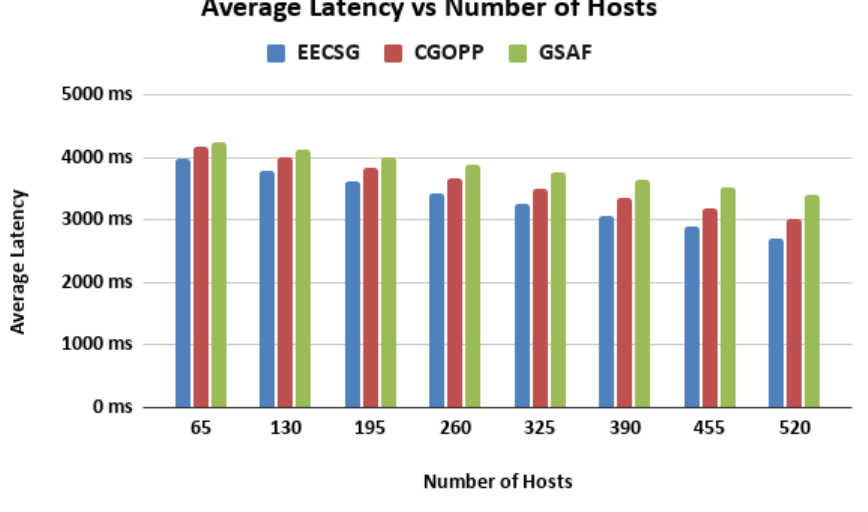
Figure 3. Average latency vs. number of